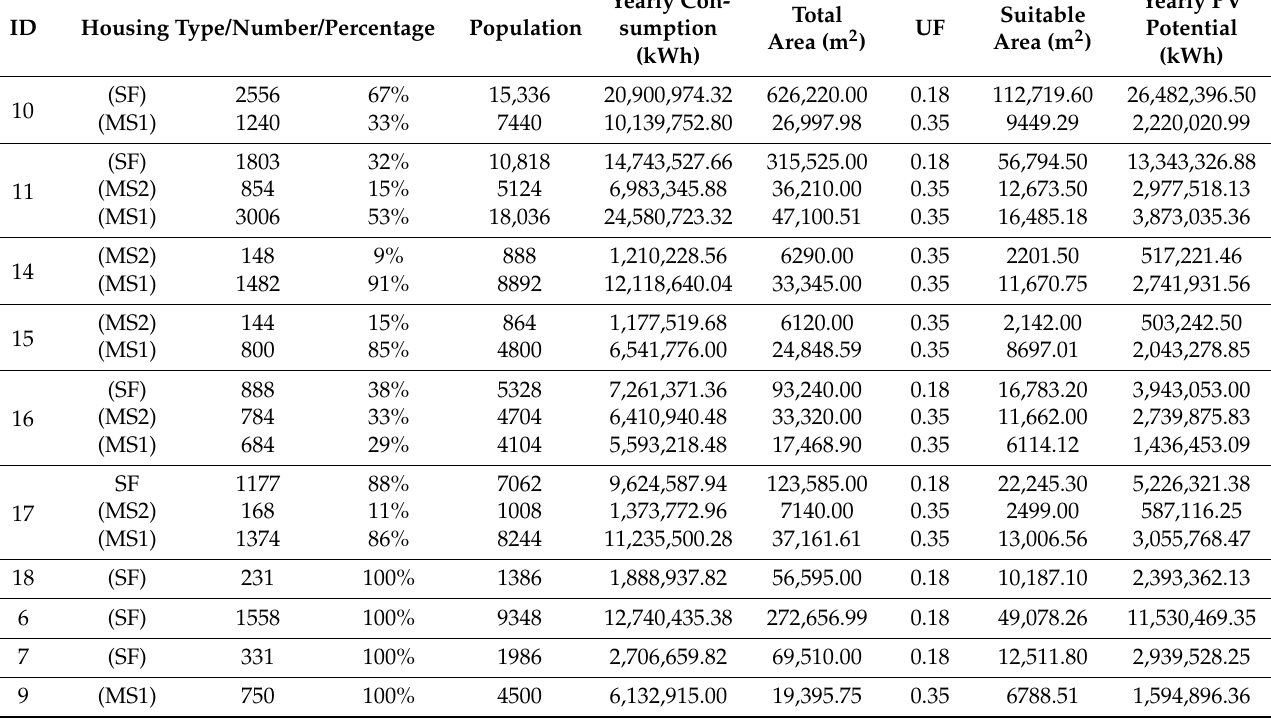
Table 4. Yearly technical potential per